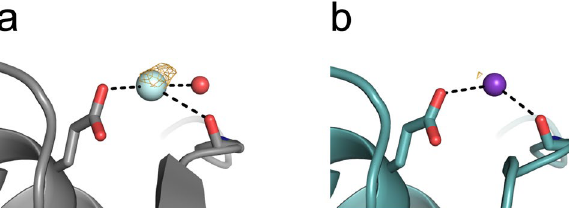
Figure 9. Comparison of cesium site 4 of p62 PH supplemented with CsCl only during SEC to the corresponding potassium site in p62 PH without CsCl treatment. Orange meshes display the anomalous density contoured at 3 σ. ( a ) Dataset #2: P62 PH supplemented with CsCl. ( b ) Dataset #1: P62 PH without CsCl supplement.